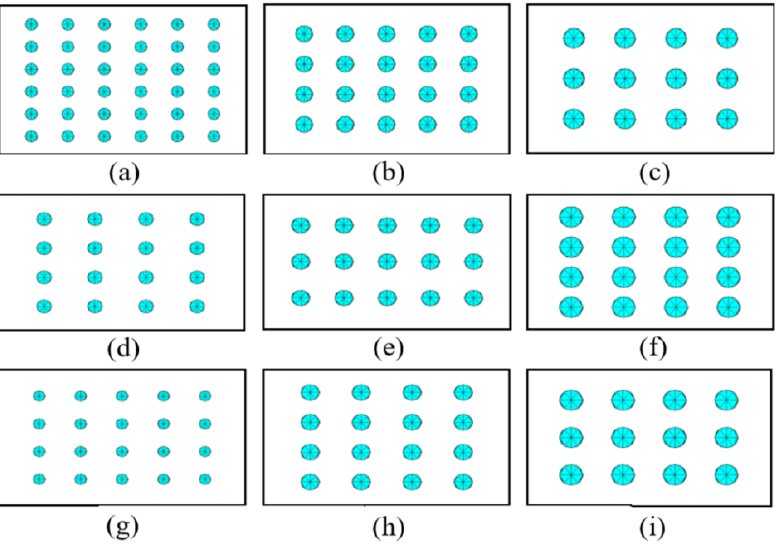
Figure 14. Nine schemes of room and pillar configurations ( a ) Scheme 1; ( b ) Scheme 2; ( c ) Scheme 3;